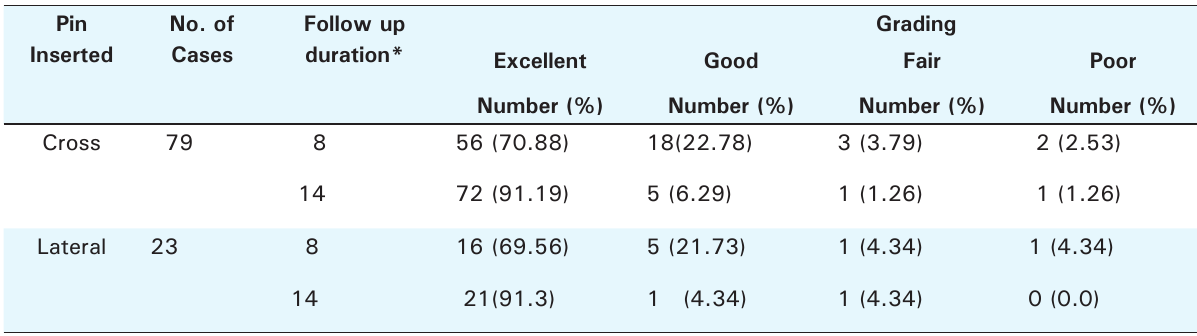
table 1. results of the evaluation of the hundred and two Patients According to the Flynn criteria Pin no. Inserted